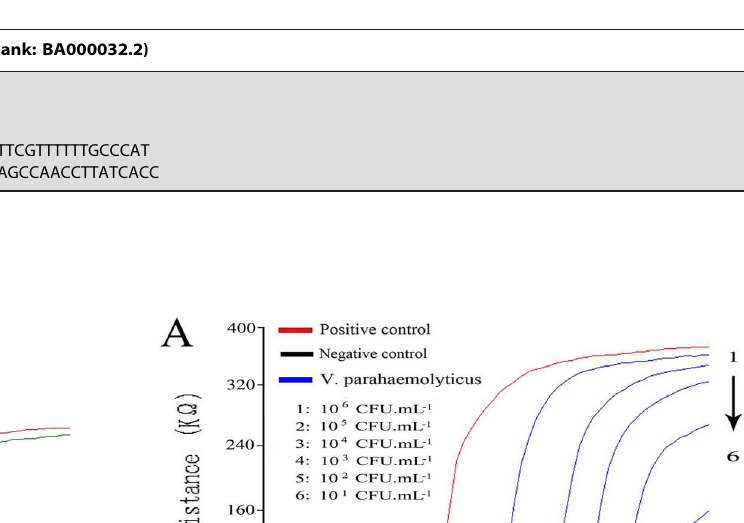
Table 1. Primers for V. parahaemolyticus.